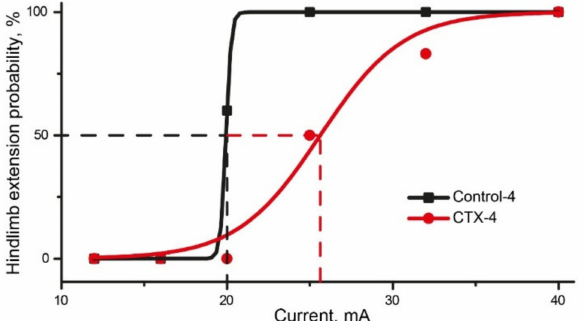
Figure 7. Results of maximal electroshock threshold test (MEST) test in CTX and control groups. Probability of hindlimb extension (squares / dots) is fitted with Boltzmann approximation. Dashed lines showEC 50